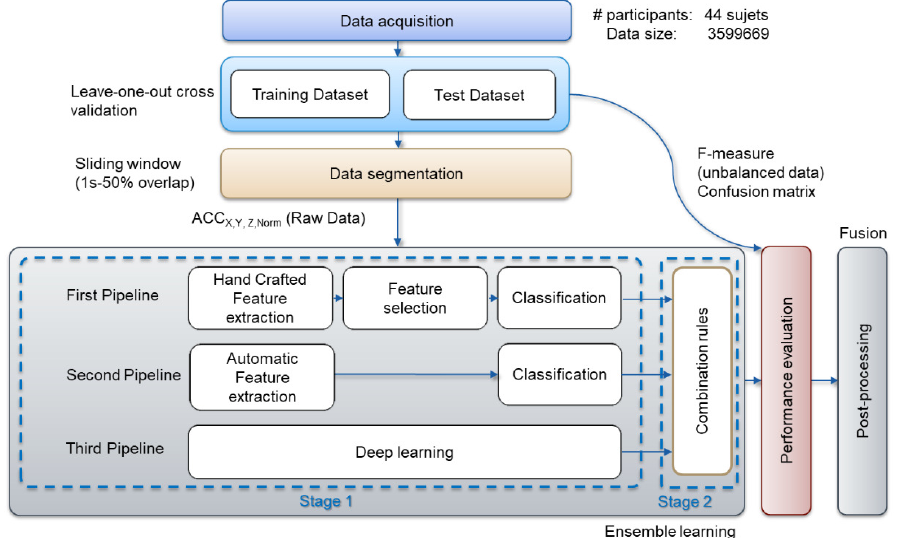
Figure 6. Overview of the proposed algorithm